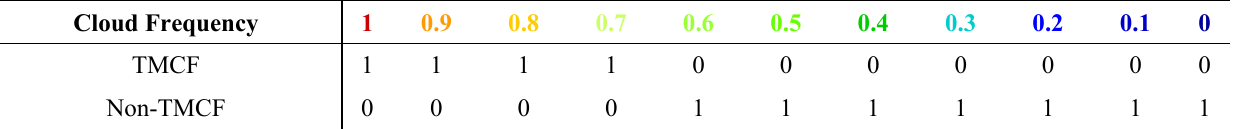
Table 2. Idealized dataset used for the construction of the ROC curve and the calculation of the AUC in Figure